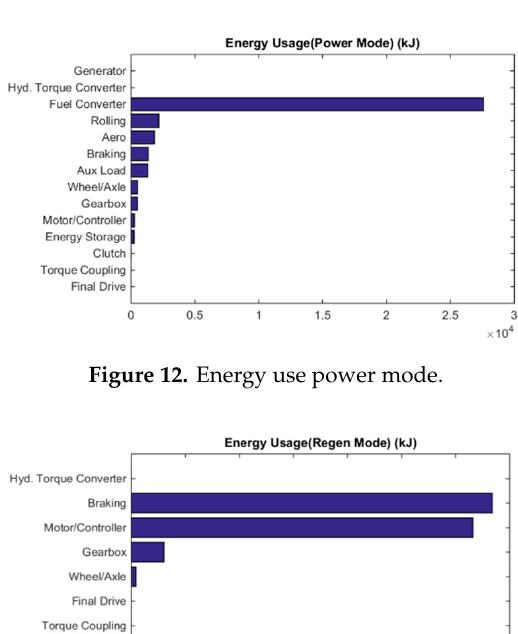
Figure 11. Motor torque-speed.